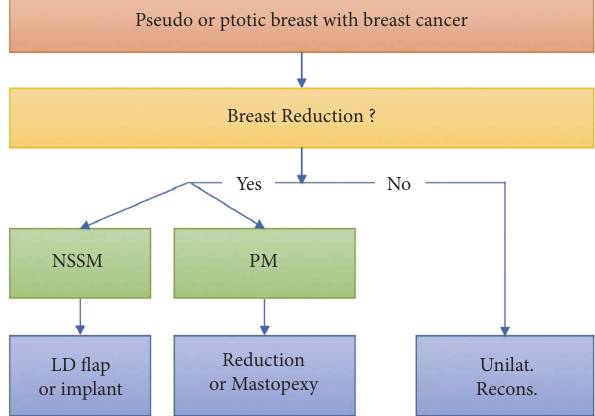
Figure 1: Algorithm for reconstructive breast surgery in true ptotic or pseudoptotic breasts. Patients with breast cancer with ptotic breasts who desired breast reconstruction underwent a nipple or skin-sparing mastectomy (NSSM) using a latissimus dorsi (LD) flap or implant or a partial mastectomy (PM) with reduction or mastopexy. Patients that did not desire breast reconstruction underwent unilateral reconstruction (unilat. recons.) and were not included in this